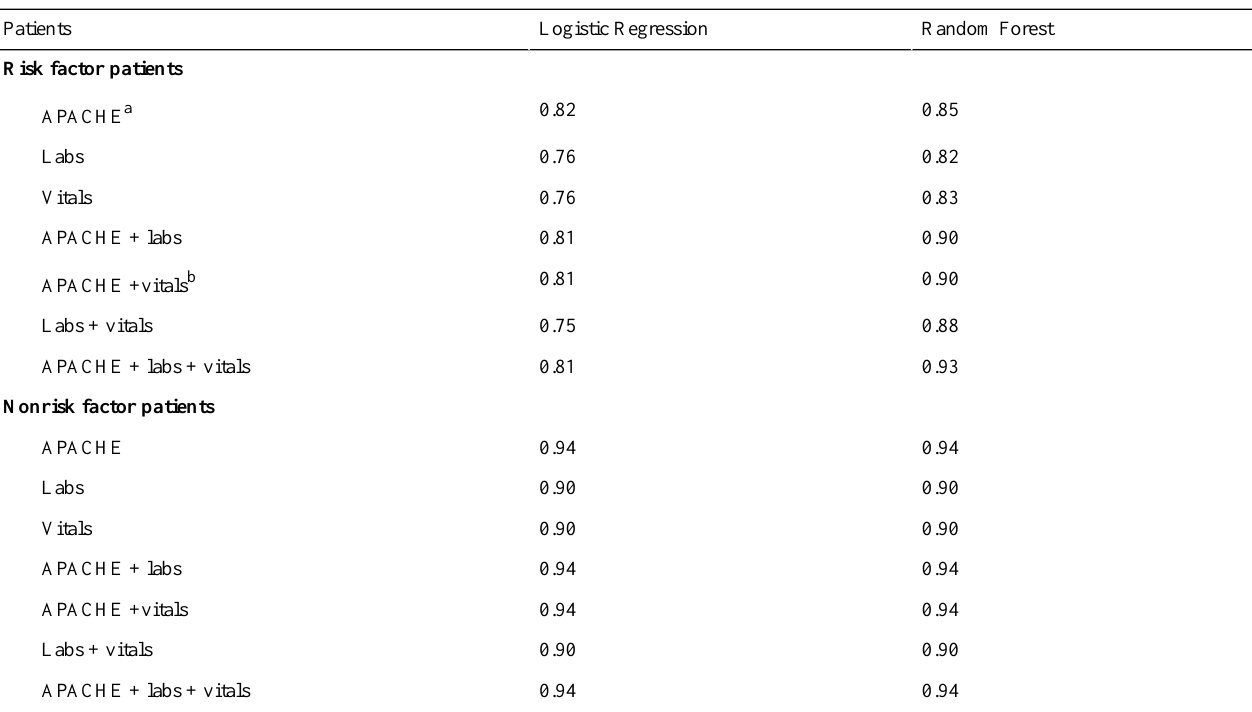
Table 3. Logistic regression and random forest F1 scores across model input combinations. Vital signs data extraction window held constant at 360 minutes for all